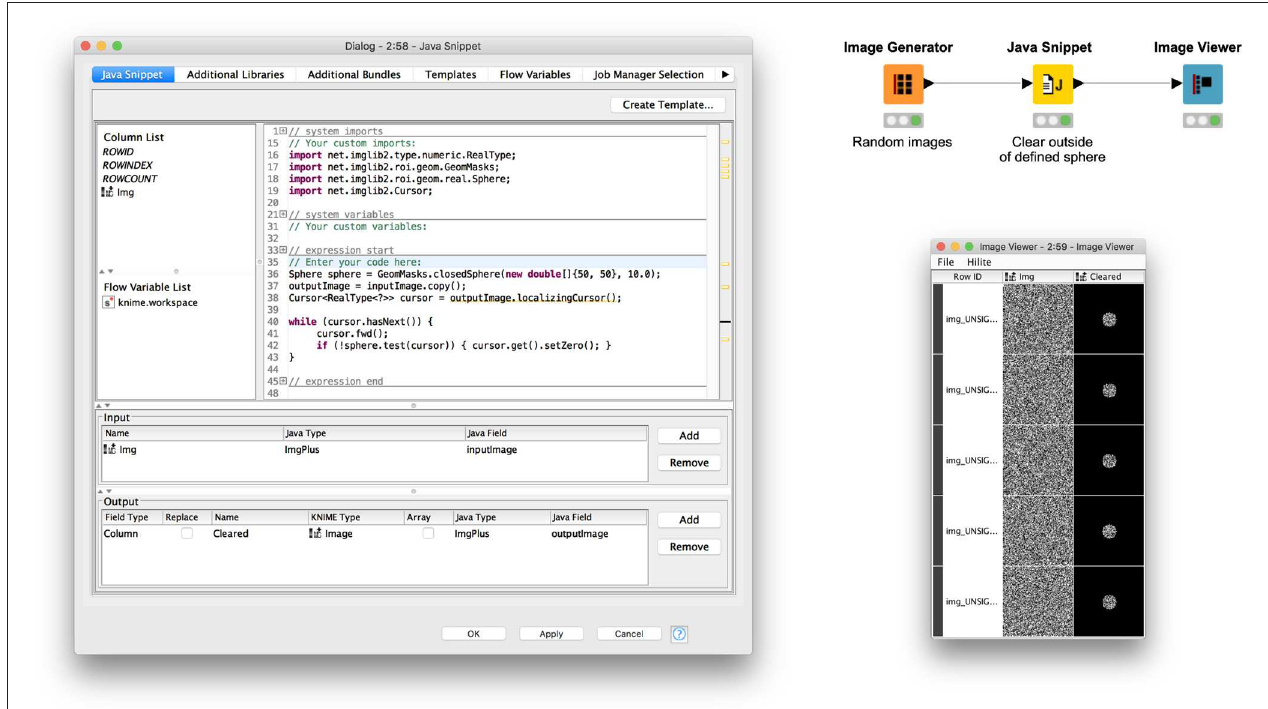
FIGURE 3 | An example Java Snippet node operating on an image region of interest using ImgLib2 libraries.